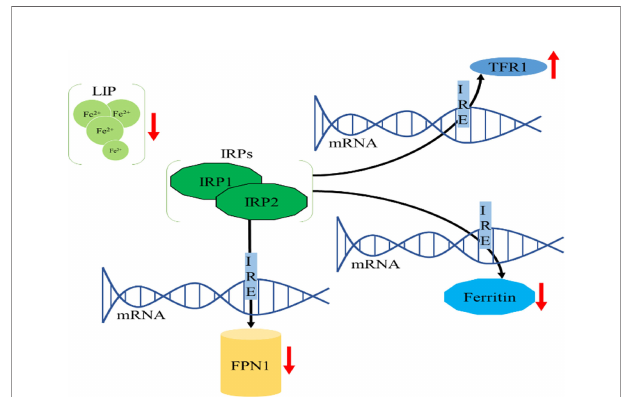
FIGURE 2 | Cellular iron metabolism. (A) When the cellular iron levels are low, IRPs bind to the 5 ’ IREs of FPN1 and FT mRNA, resulting in translation repression. Additionally, IRPs bind to 3 ’ IREs in TFR1 mRNA to stabilize the DMT1 mRNA and increase TFR1 protein synthesis. These two effects can increase intracellular iron. (B) When the cellular iron levels are high, IRP1 converts to cytosolic aconitase and IRP2 is degraded, preventing IRP1 and IRP2 from binding to the IREs of these mRNAs. This permits unimpeded translation of FPN1 and FT and fosters degradation of DMT1 and TFR1 mRNA, leading to decreased cytosolic